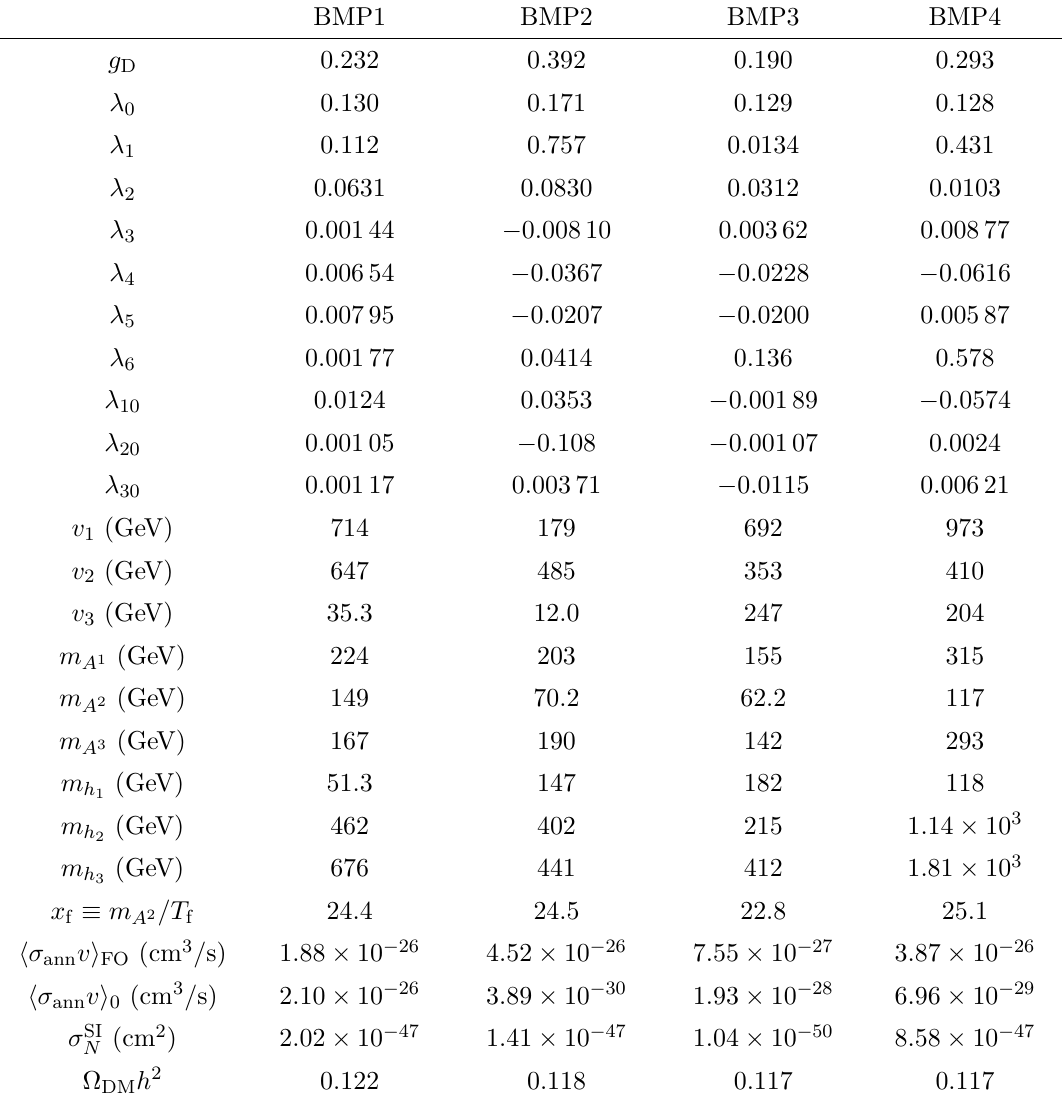
Table 1. Properties of four benchmark points, corresponding to four curves in figure